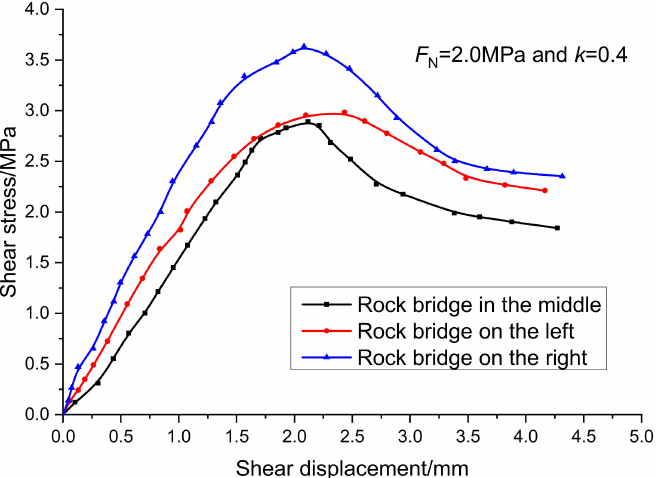
Figure 13. Relationship curves between tangential stress and displacement under di ff erent arrangement of the rock